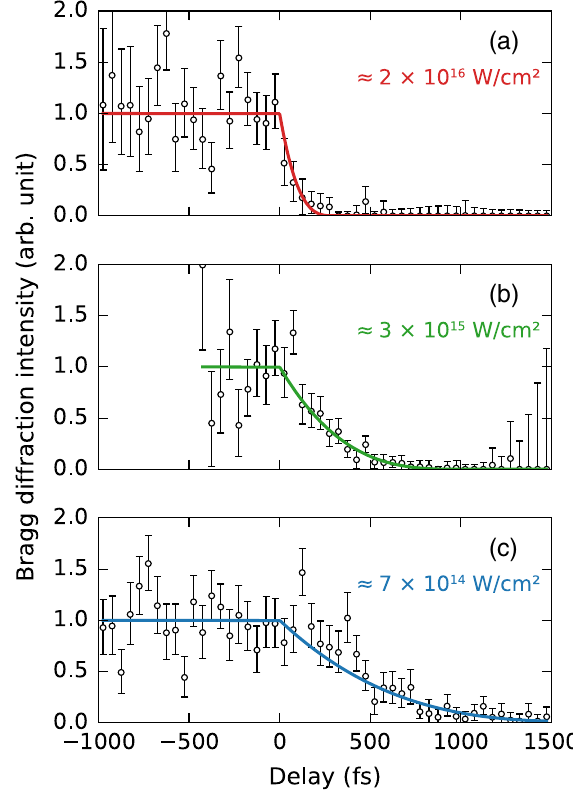
FIG. 3. Delay dependence of f 111 g diffraction intensities of fcc Xe clusters I ð t Þ at (a) I NIR ¼ ð 2 . 2 (cid:3) 0 . 6 Þ × 10 16 W = cm 2 , (b) I NIR ¼ ð 3 . 2 (cid:3) 0 . 5 Þ × 10 15 W = cm 2 , and (c) I NIR ¼ ð 7 . 3 (cid:3) 0 . 8 Þ × 10 14 W = cm 2 . Solid curves show the fitting results with the nanoplasma model. For details of the model, see main